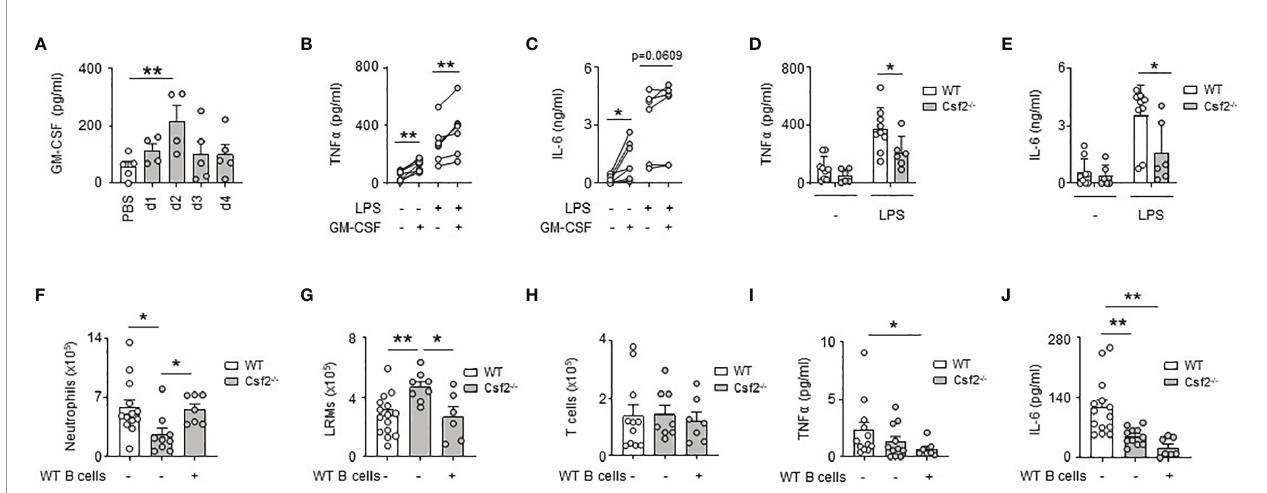
FIGURE 3 | GM-CSF-expressing B cells contribute partially to GM-CSF-induced PS in fl ammation. (A) Levels of GM-CSF in pleural space 1, 2, 3 and 4 days after i.t. infection of 5x10 6 CFU of E. coli or PBS (n=4-5 mice per time point). (B, C) Levels of TNF a (B) and IL-6 (C) in culture supernatant of pleural immune cells from naive mice 24h after ex vivo stimulation with GM-CSF in presence or in absence of LPS (n=5 mice). (D, E) Levels of TNF a (D) and IL-6 (E) in culture supernatant of pleural immune cells from naive WT or Csf2 -/- mice 24h after ex vivo stimulation with LPS (n=6-9 mice). (F – H) Enumeration of neutrophils (F) , LRMs (G) and T cells (H) in pleural space of WT or Csf2 -/- mice 24h after intrapleural injection of LPS. WT and Csf2 -/- mice received PBS or WT pleural B cells into the pleural space at the same time of LPS injection (n=7-13 mice). (I, J) Levels of TNF a (I) and IL-6 (J) in pleural space of WT or Csf2 -/- mice 24h after intrapleural injection of LPS. WT and Csf2 -/-